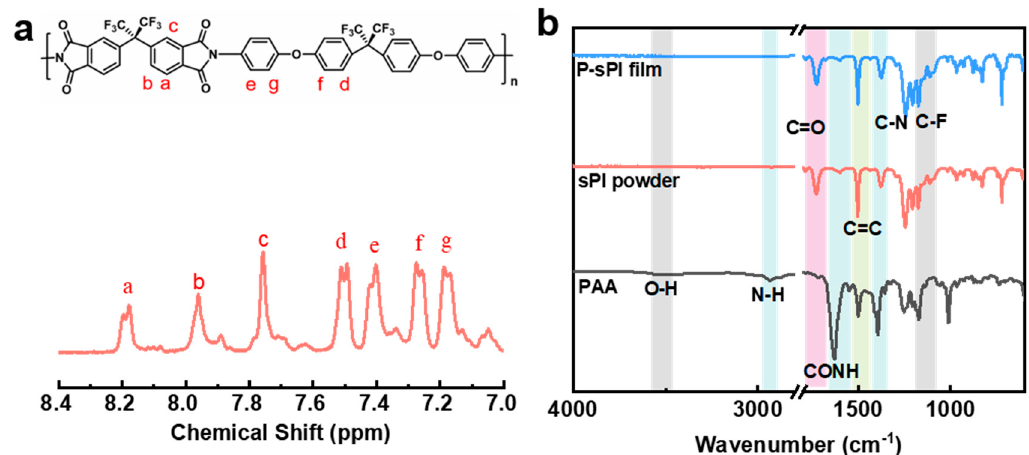
Figure 2. ( a ) 1 H-NMR spectrum of sPI by using d 6 -DMSO as the solvent; ( b ) FTIR spectra of inter- mediate PAA, synthesized sPI, and porous sPI film.